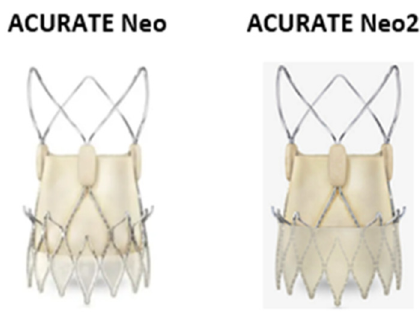
Figure 3. The ACURATE neo and neo2 self-expandable valve consist of a porcine pericardial tissue bio-prosthesis stitched into a self-expanding Nitinol stent and covered on the inside and outside with an anti-PVL porcine pericardial skirt. The open upper frame of the device open frame provides unrestricted access for future interventions.